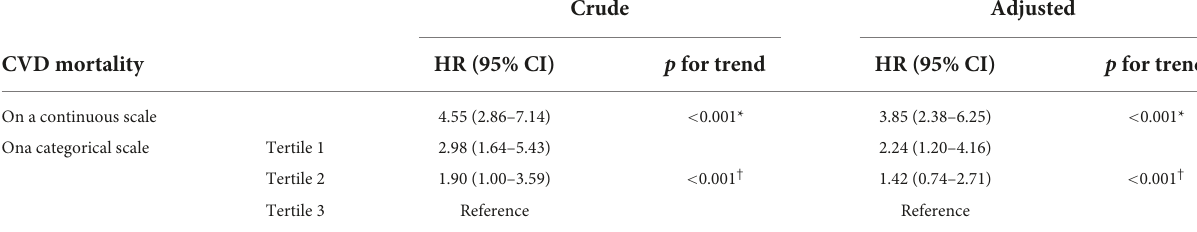
TABLE 2 Association of albumin levels and cardiovascular disease (CVD) mortality in the COX model.